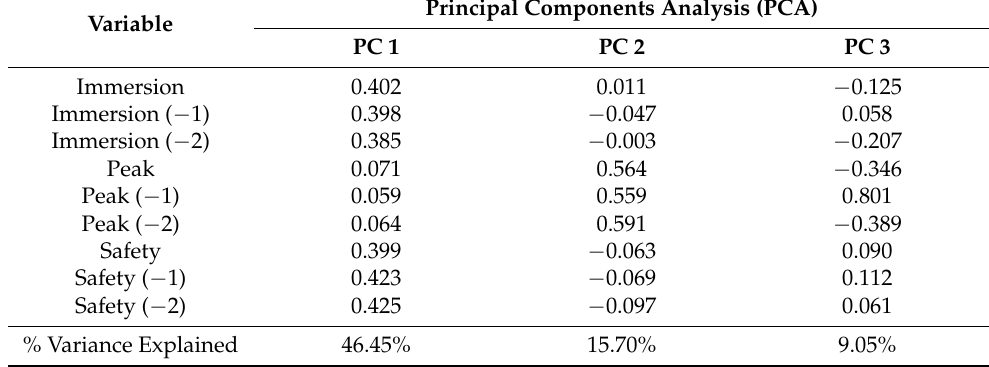
Table A4. Principal components loadings.